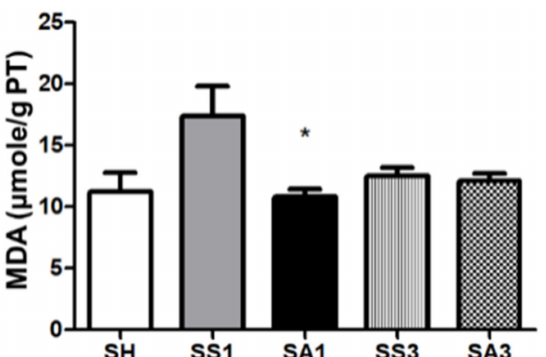
Figure 8. Lipid peroxide malondialdehyde (MDA) concentrations in liver tissues. SH, sham group without a sleeve gastrectomy (SG) ( n = 8); SS1 and SS3, saline groups sacrificed on day 1 or 3 after the SG; SA1 and SA3, arginine groups sacrificed on day 1 or 3 after the SG. n = 10 for each SG group. Values are presented as the mean ± SEM. A two-way analysis of variance (ANOVA) with the Bonferroni post-hoc test was used to analyze differences among the SH and gastrectomy groups. * Significantly differs from the SS group at the same time point ( p <